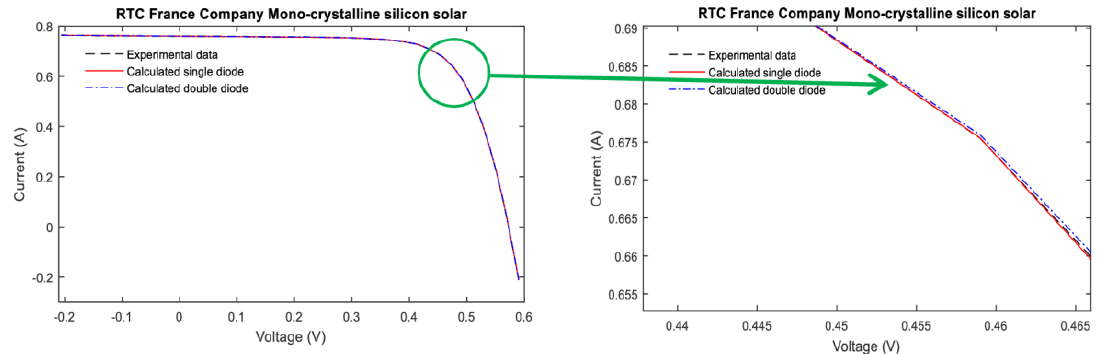
Figure 9. Compared experimental current-voltage and power-voltage of the mono-crystalline single diode silicon solar cell, RTC France Company.